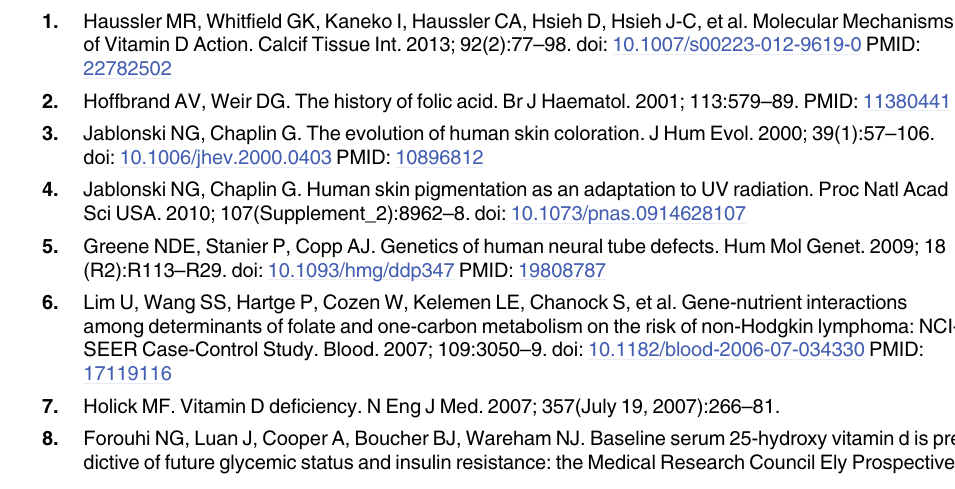
S5 Fig. Candidate regulatory variants and DNase I hypersensitivity clusters in CXXC1 , LRP5 and RUNX2 . Green and orange filled cells indicate the tissues and DNase I hypersensi- tivity cluster regions, respectively, that are associated with an ENCODE functional annotation for each SNP that was short listed. Candidate regulatory variant rs ids and positions (in build GRCh37) are shown. S1 Table. Vitamin D gene sets. S2 Table. Folate gene sets. S3 Table. Summary statistics of frequency-spectrum-based neutrality tests in vitamin D, folate and control gene sets. S4 Table. Genes showing positive selection